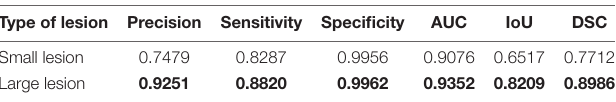
TABLE 2 | Comparison of the segmentation results of OT-Unet (Res2Net) in different sizes of lesion areas. Type of lesion Precision Sensitivity